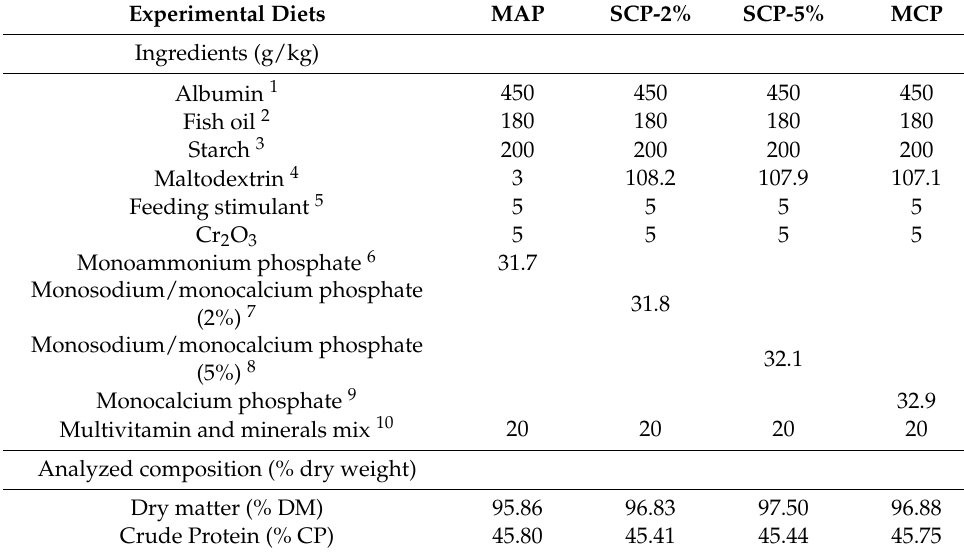
Table 1. Formulation and proximate composition of the experimental